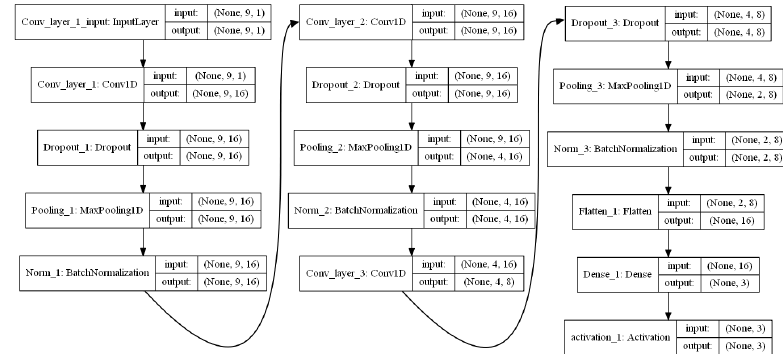
Figure 12: Architecture of the best trained